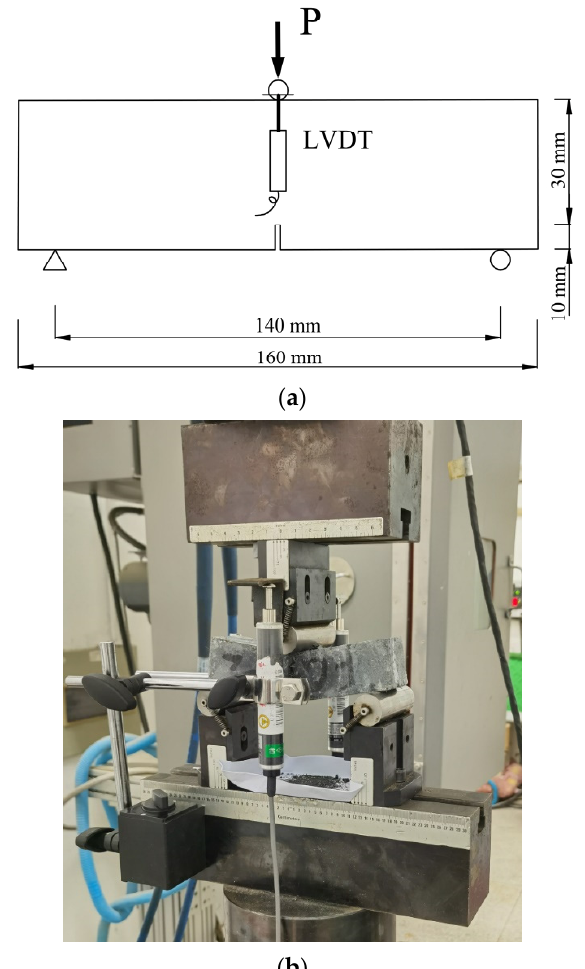
Figure 2. Schematic ( a ) and experimental setup ( b ) of the three-point bending test.